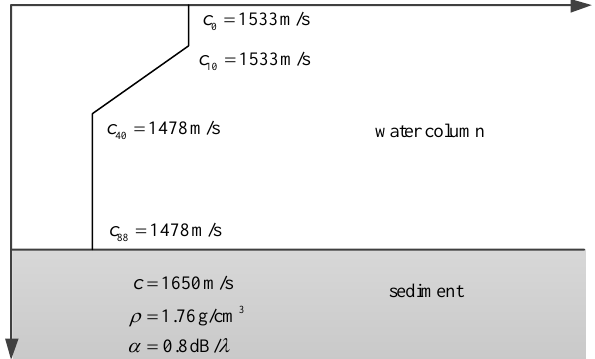
( b ) Figure 2. Variation of the real part of sound pressure versus time: ( a ) the overall view of the first 6000 seconds and ( b ) the enlarged detail between the 5000th and 5050th seconds. In the simulation, the observation period is set to be